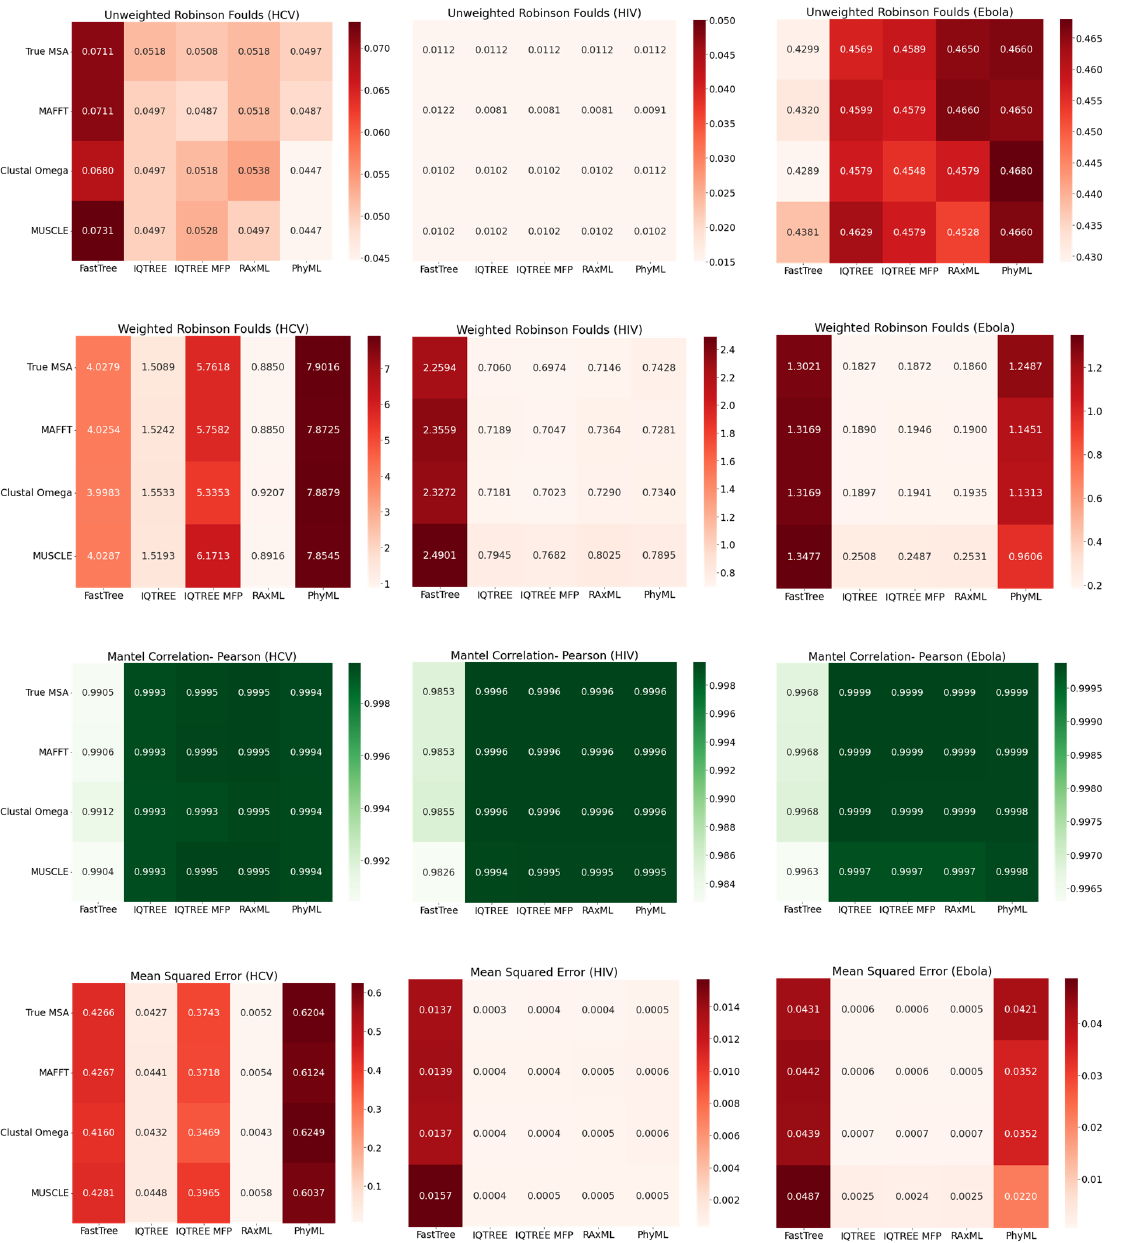
Figure 4. Heat maps comparing the accuracy of phylogenies inferred with FastTree, IQ-TREE (GTR), IQ-TREE (MFP), RAxML-NG, and PhyML from the MAFFT, Clustal Omega, MUSCLE, and true MSAs. Each value of Unweighted Robinson–Foulds (URF), Weighted Robinson–Foulds (WRF), Pearson Mantel Correlation, and Mean Squared Error shown is the average of 10 simulation replicates. Heatmaps showing Spearman Mantel Correlation can be found in Supplementary Figure S2.